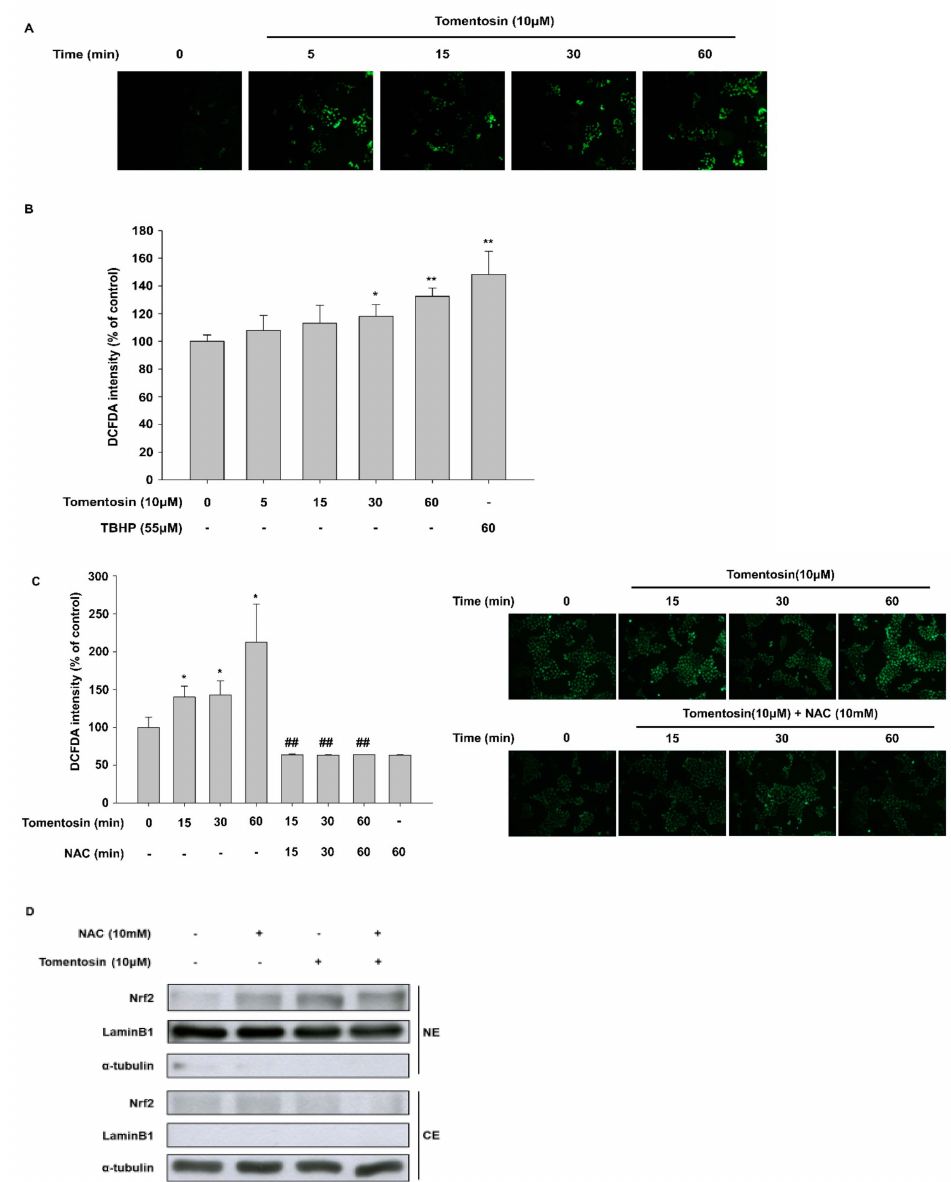
Figure 4. Tomentosin-derived ROS production mediates activation of nuclear factor erythroid 2-related factor 2 (Nrf2). ( A , B ) HaCaT cells were incubated with 10 µ M tomentosin for the indicated time periods (5–60 min) and treated with 20 µ M 2 (cid:48) ,7 (cid:48) dichlorofluorescin diacetate (DCFDA) for 20 min. The cells were then subjected to fluorescence microscopy (Original magnification = 10 × ) ( A ) or fluorescence intensity analysis ( B ). The results are shown as the mean ± SD of triplicates. * p < 0.05 vs. untreated group. ** p < 0.01 vs. untreated group. ( C , D ) Cells were treated with 10 µ M tomentosin in the presence or absence of 10 mM N -acetyl- L -cysteine (NAC) for the indicated time points and then treated with 20 µ M DCFDA for 20 min. The cells were subjected to fluorescence intensity analysis ( C, left ) and fluorescence microscopy ( C, right )(Original magnification = 10 × ). The results are shown as the mean ± SD of triplicates. * p < 0.05 vs. untreated group. ## p < 0.01 vs. tomentosin-treated group. ( D ) Cells were treated with 10 µ M tomentosin in the presence of 10 mM NAC for 24 h. The treated cells were collected, and the nuclear and cytoplasmic cellular fractions were analyzed by Western blotting. α -tubulin and lamin B1 were introduced as controls for cytoplasmic and nuclear protein extracts, respectively. NE, nuclear extracts; CE, cytosolic